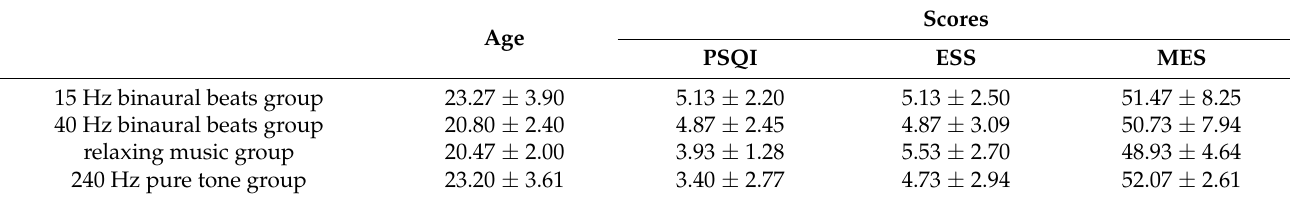
Table 1. Basic information (M ± SD).